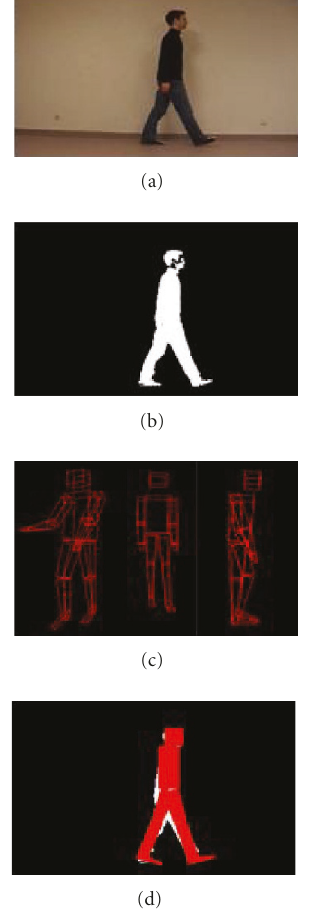
Figure 11: Estimation of the likelihood of the model. (a) The real image is obtained using a digital video camera. (b) The silhouette is extracted. (c) The virtual model is calculated. (d) The model is compared with the